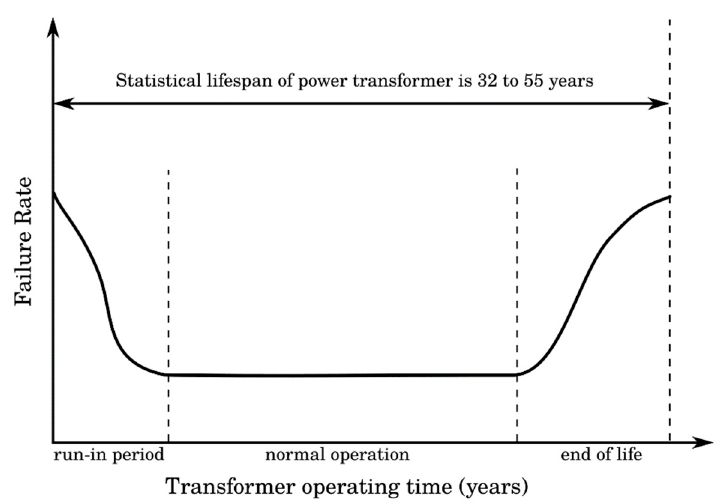
Figure 1. General “bathtub” pattern as the failure rate of power transformers.